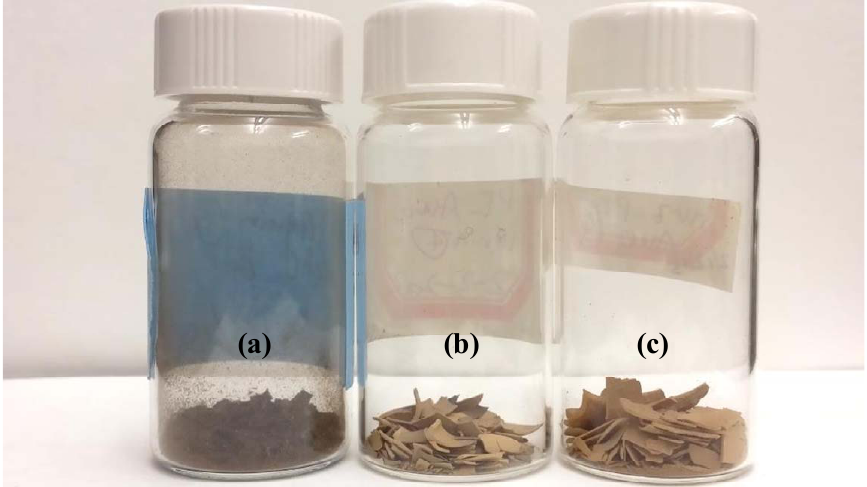
Figure 1. The picture shows kraft lignin compared to AWO lignin ( a ) Kraft lignin; ( b ) PTL ; ( c ) E PTL 1 MK 1